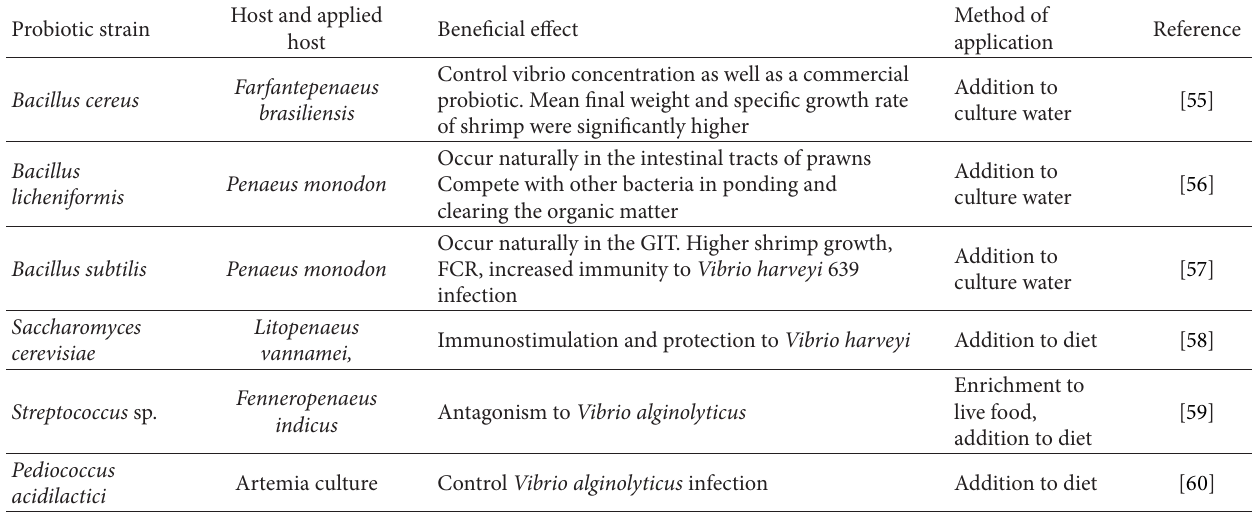
Table 5: List of microbial strains authorized as probiotics under Council Directive